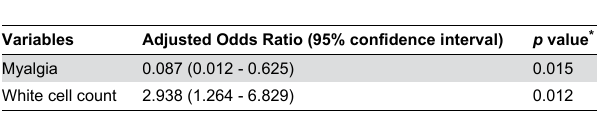
Table 4. Risk Factors for fatality in adult dengue